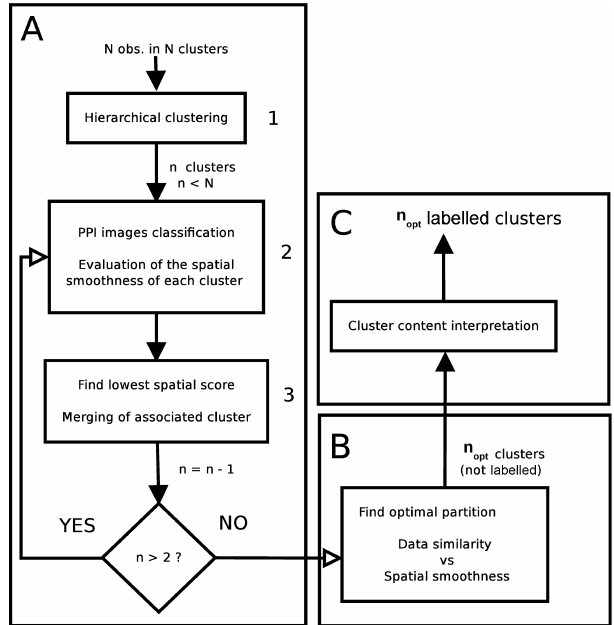
Figure 2. Flow chart of the clustering algorithm presented in Sect.